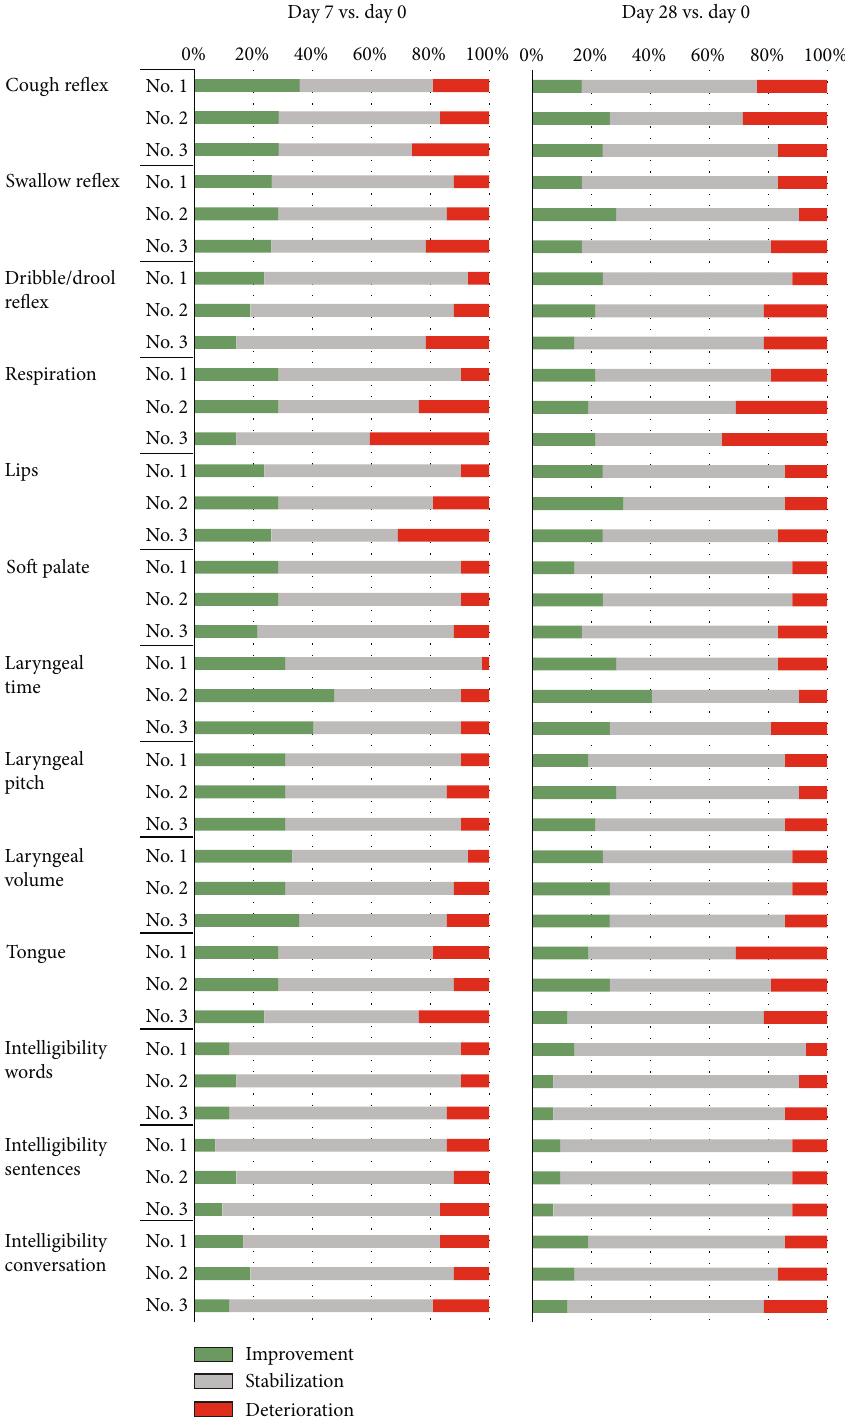
Figure 2: FDA scale assessment results after 7 and 28 days post each injection of Lin − cells (No. 1, No. 2, No. 3) compared to the baseline values (day 0 of each procedure). Colors represent the percentage of patients (n=42) in which the analyzed parameter improved (green), remained stable (gray) or deteriorated